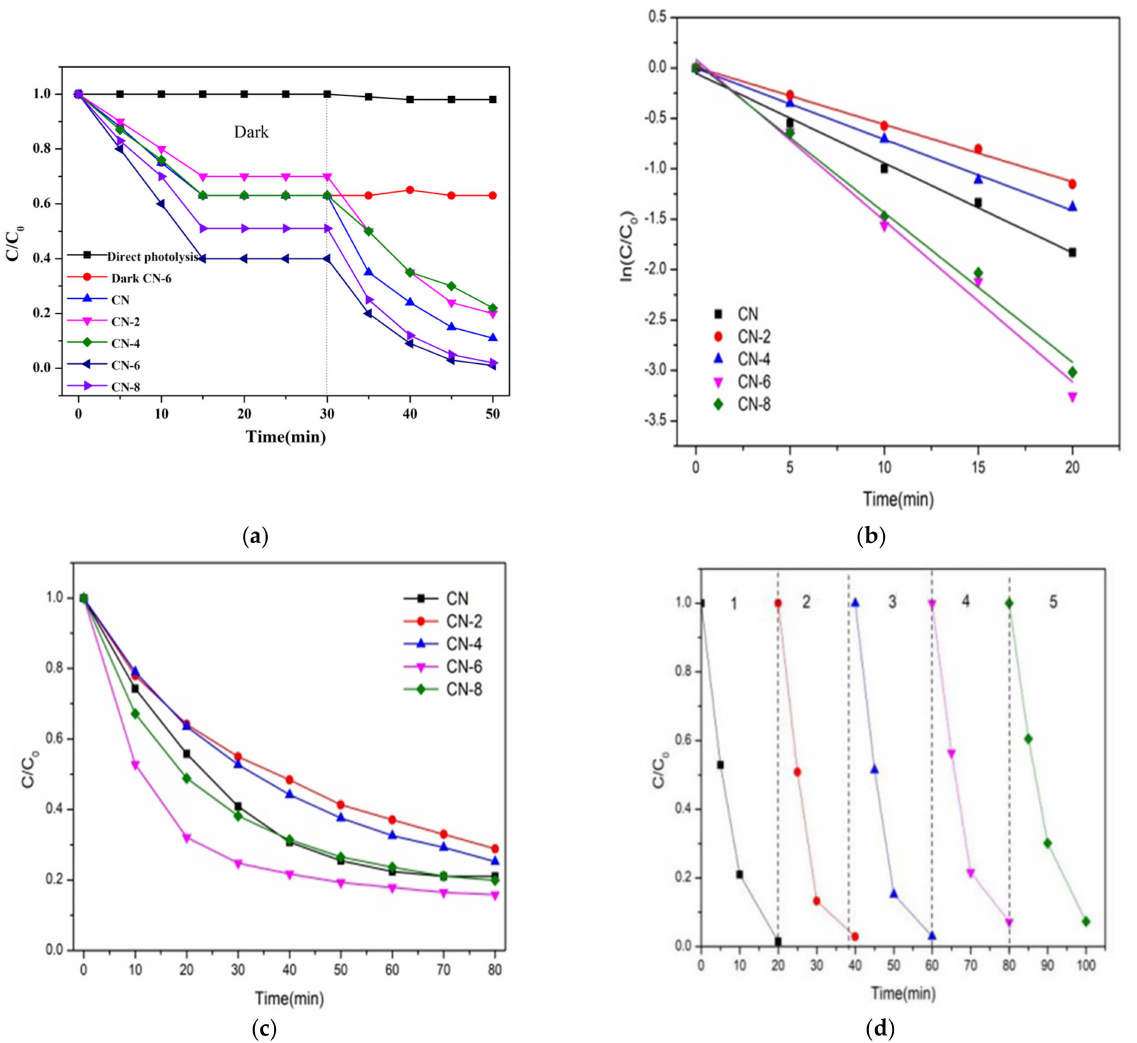
Figure 9. ( a ) Adsorption property and photocatalytic activity of samples towards the degradation of RhB under visible light irradiation; ( b ) the kinetic fit for RhB degradation; ( c ) photocatalytic activity of samples for TC breakdown under visible light and ( d ) during the photocatalytic breakdown of RhB over CN-6 when exposed to visible light, the photocatalytic activity